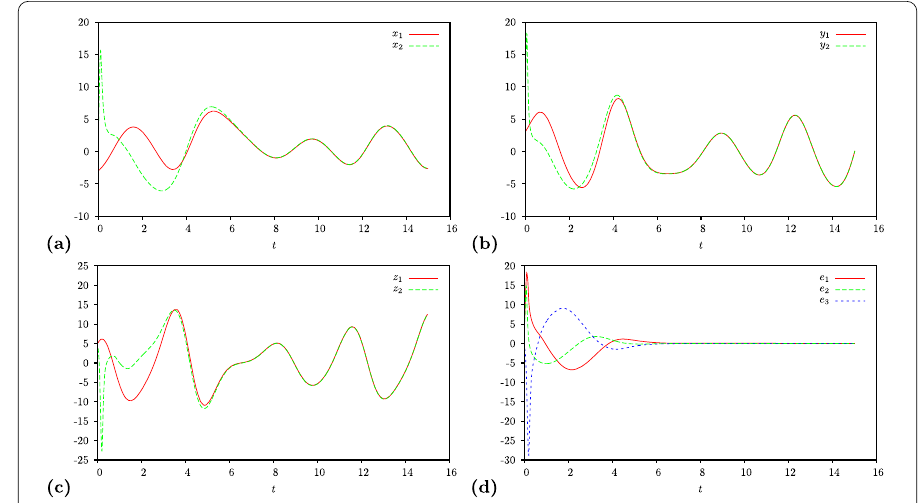
Figure 1 State trajectories of drive system (25) and response system (25): ( a ) signals x 1 and x 2 ; ( b ) signals y 1 and y